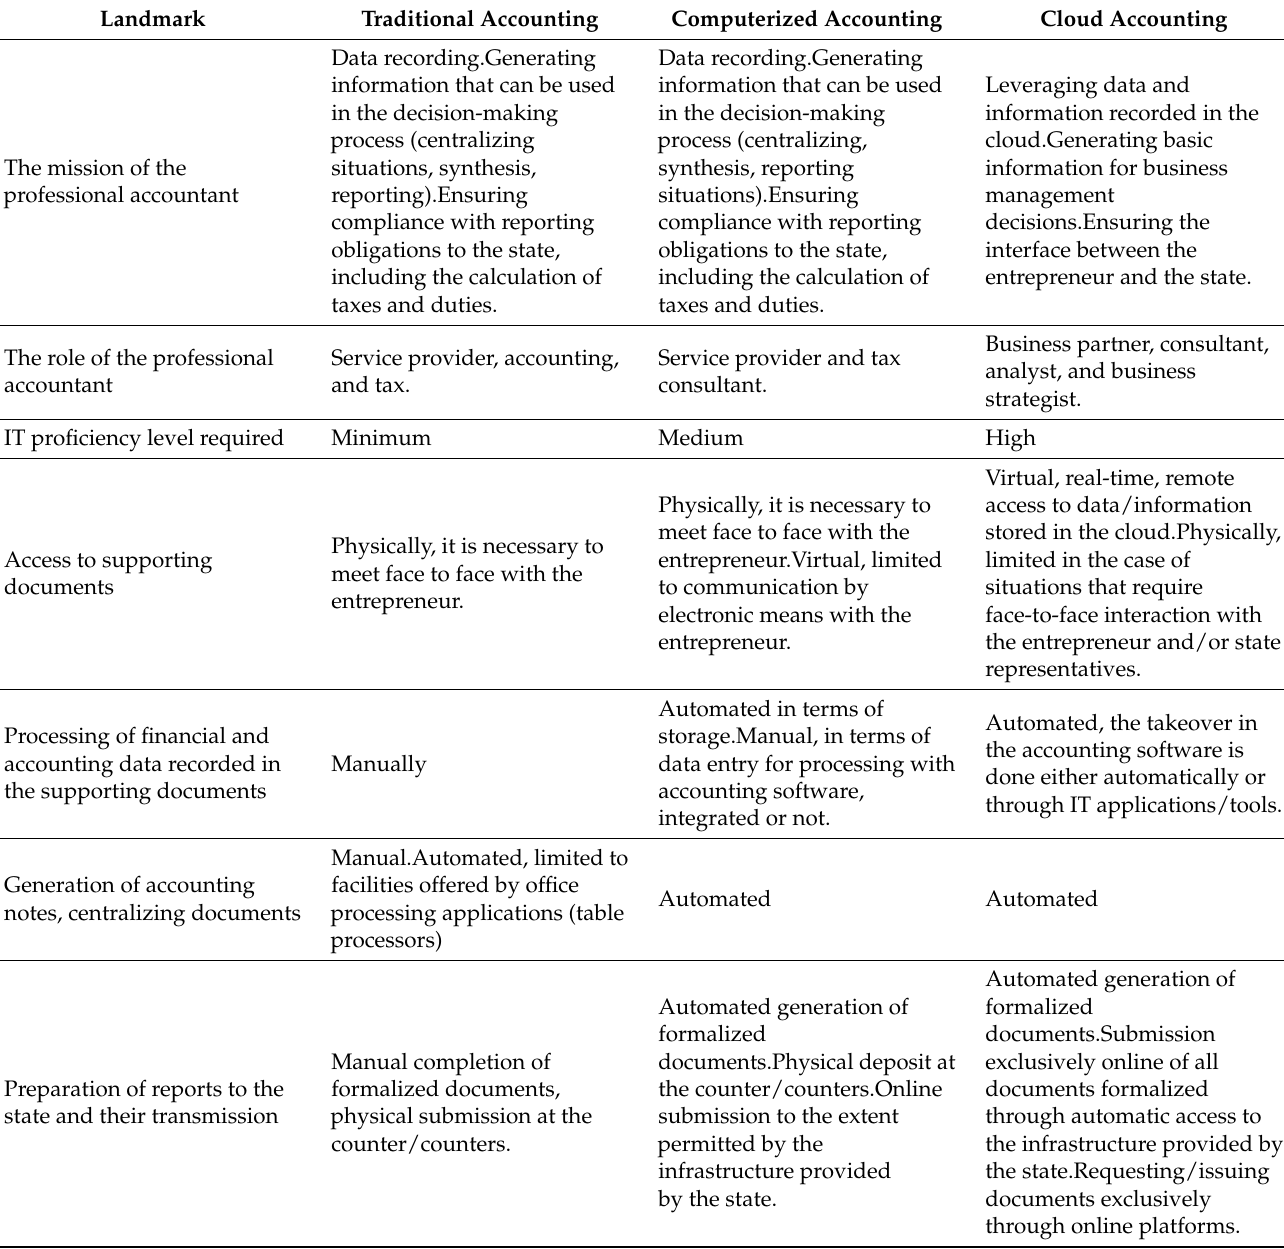
Table 19. The role of the professional accountant in the management of the business and the manage- ment of the communication with the state. Paradigm